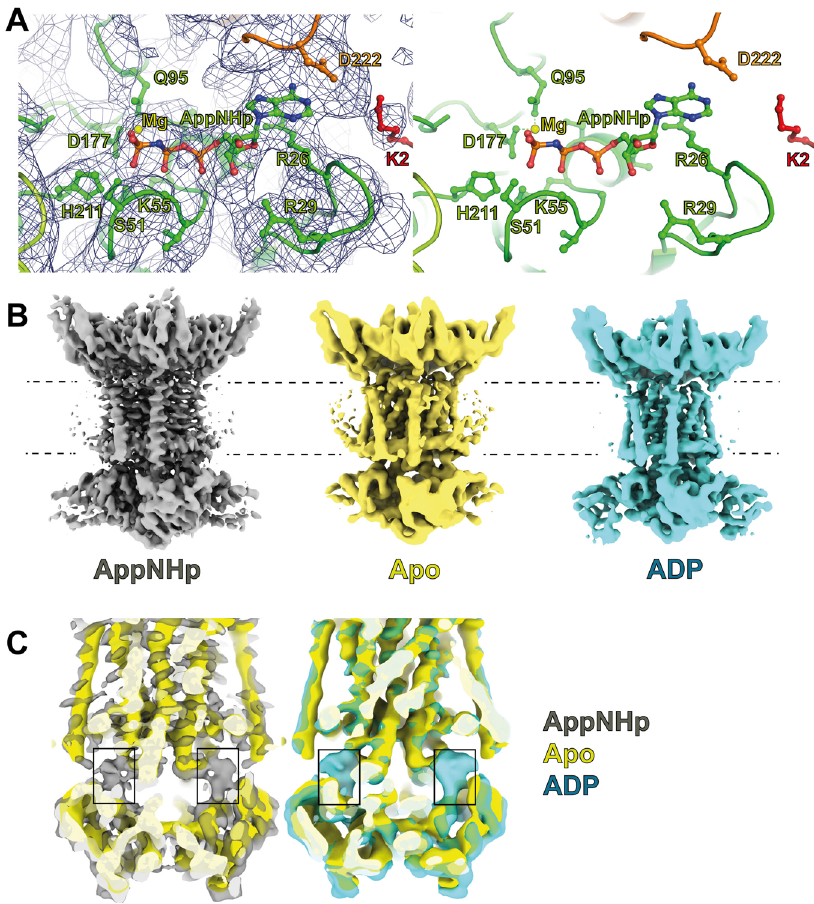
Fig. 4 Nucleotide position in the MlaBDEF ab structure. A AppNHp is bound at the interface of MlaE (orange), MlaD (red) and MlaF (green). B maps of MlaBDEF ab bound to AppNHp (grey), its apo state (yellow) and bound to ADP (cyan). C The overlay of the maps unambiguously con fi rms the presence of nucleotide in the AppNHp and ADP maps, but not in the apo map. Nonetheless, no overall structural changes are observed.